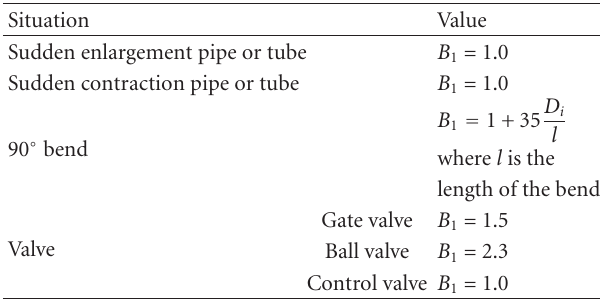
Table 7: Values of B 1 in the case of wet steam.